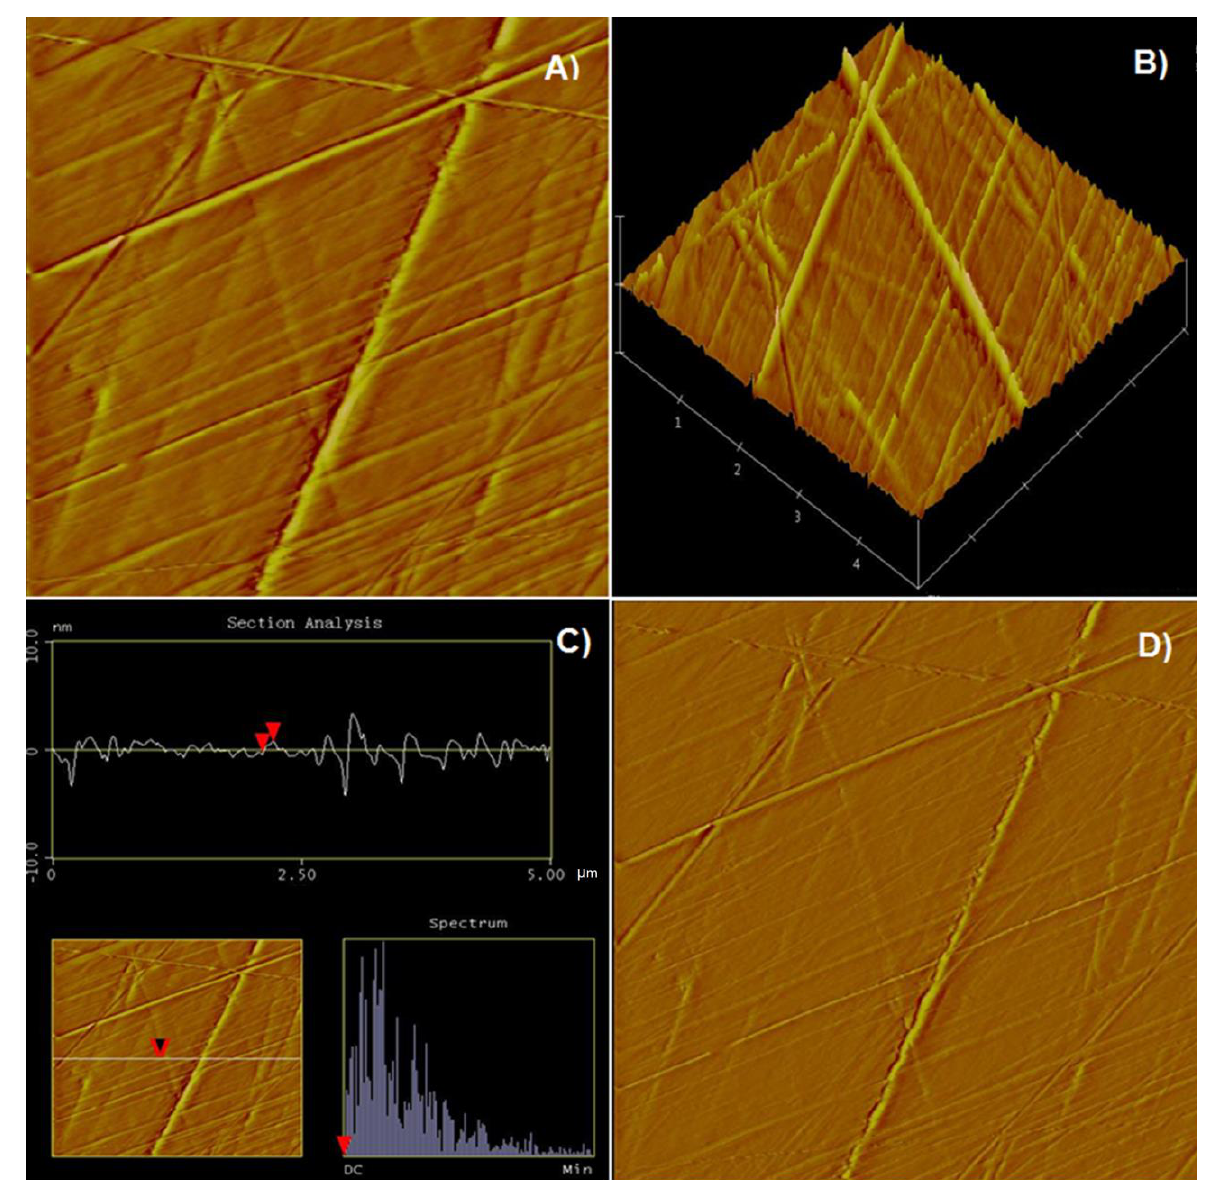
Figure 1. AFM images of a bornite surface in air. ( A ) The 5 µm × 5 µm height image with a data scale of 20 nm, ( B ) the 3D image, ( C ) the section analysis (the red arrows indicate the top and the bottom of an average asperity) and ( D ) the deflection image with a data scale of 10 nm.